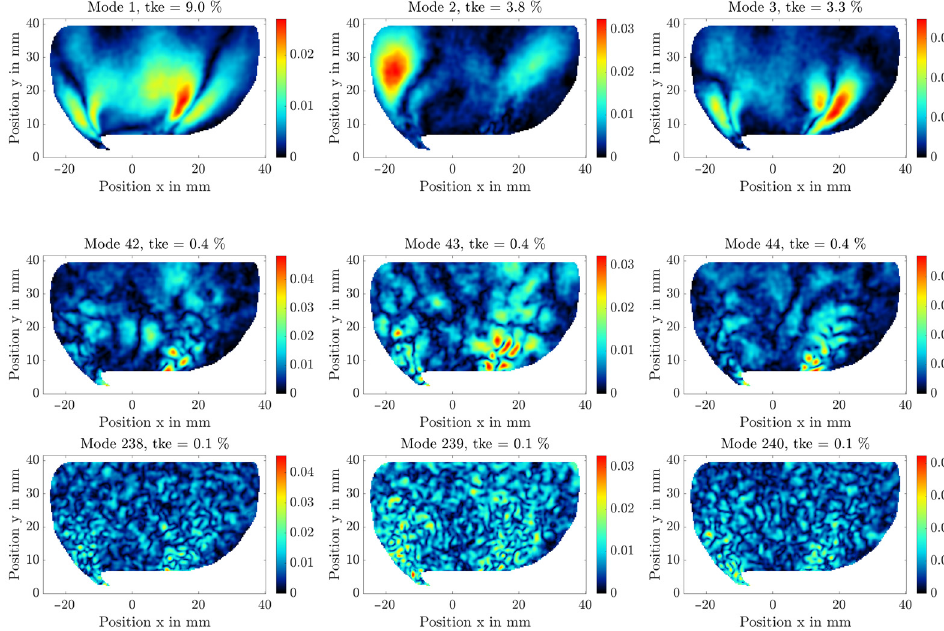
Figure 17. Turbulent kinetic energy per mode and percentage amount of cumulated turbulent kinetic energy ( left ) and time coefficients of the modes 1, 42, and 238 ( right ) at 4 mm and 39.6 kg/h calculated from PIV measurements.